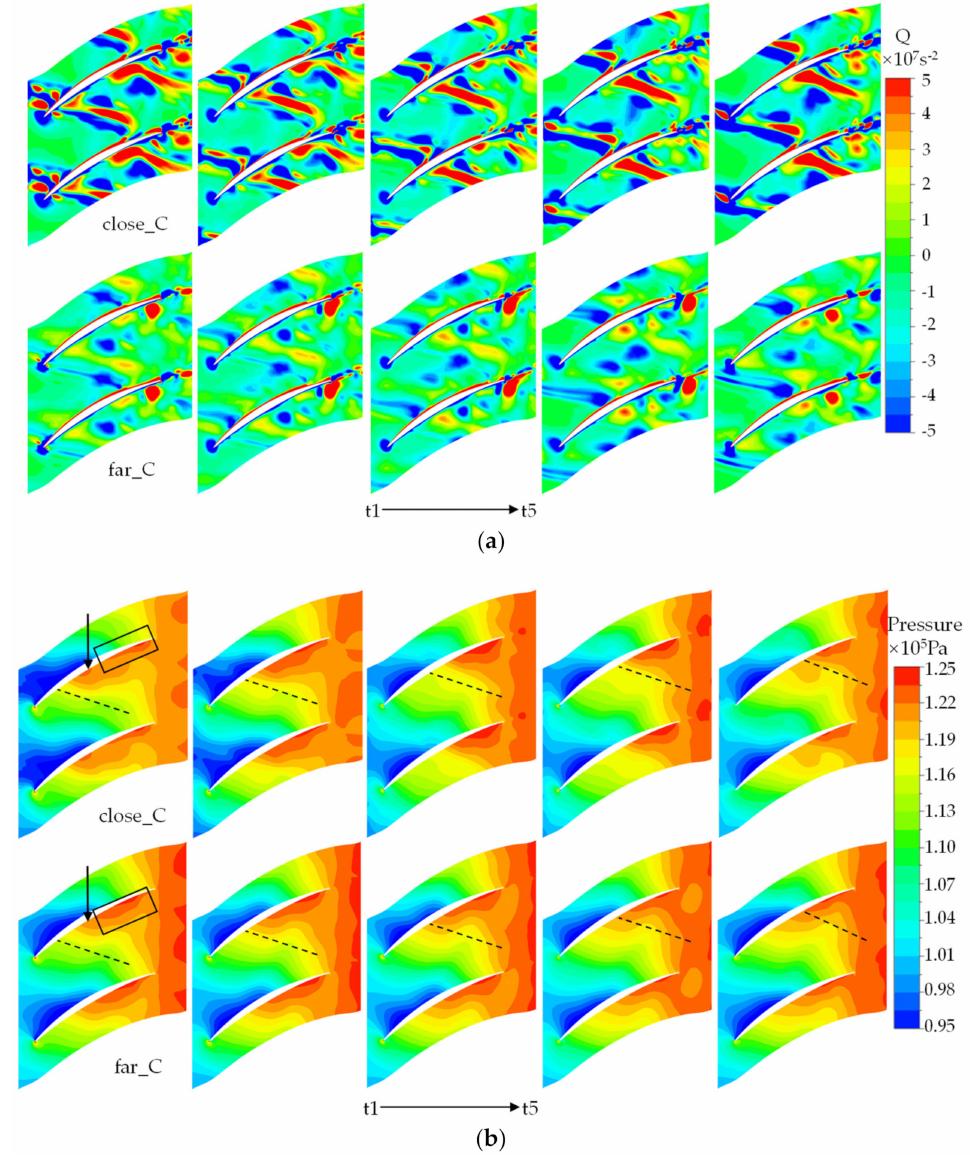
Figure 15. Flow field comparison at five time-steps. ( a ) Q; ( b )